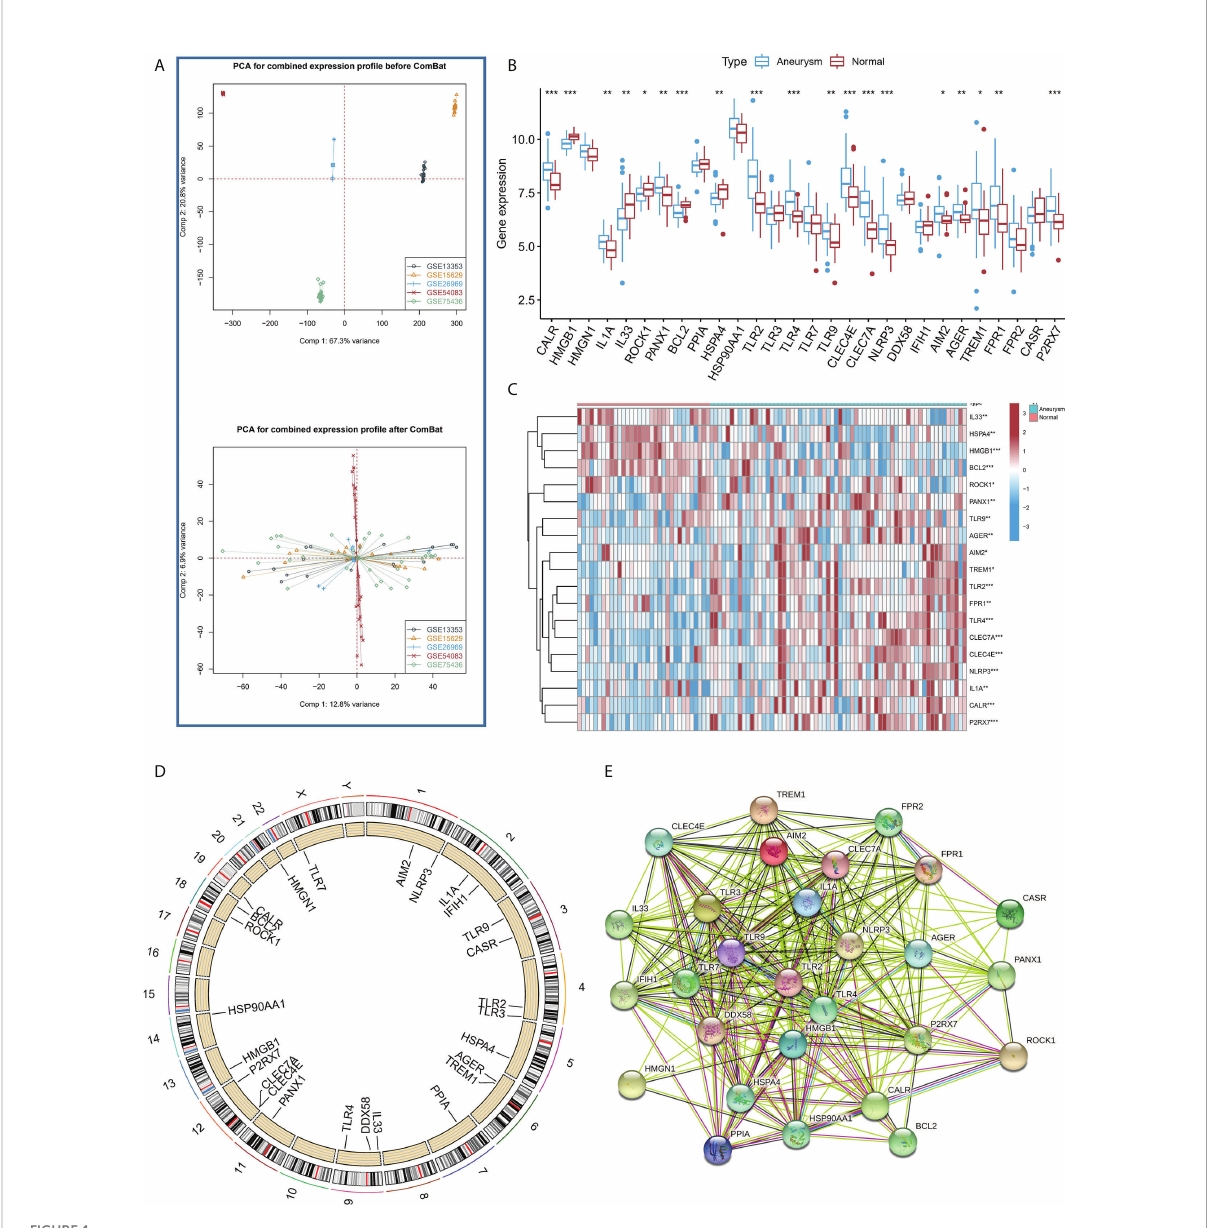
FIGURE 1 (A) PCA results for the combined expression pro fi le before Combat and after Combat. (B) The box plot demonstrated the transcriptome expression status of 28 immunogenic cell death (ICD) regulators between intracranial aneurysms (IA) and normal samples. (C) The heatmap plot showed signi fi cant differences in terms of the expression levels of 19 regulators between IA and normal samples. (D) . The landscape of gene expression changes of ICD-regulators in the IA. The location of the CNV alteration of ICD-regulators on the 22 chromosomes derived from the GEO database. (E) The composition summary of the ICD-regulators and PPI among the 28 ICD-regulators. *P < 0.05, **P < 0.01, ***P <